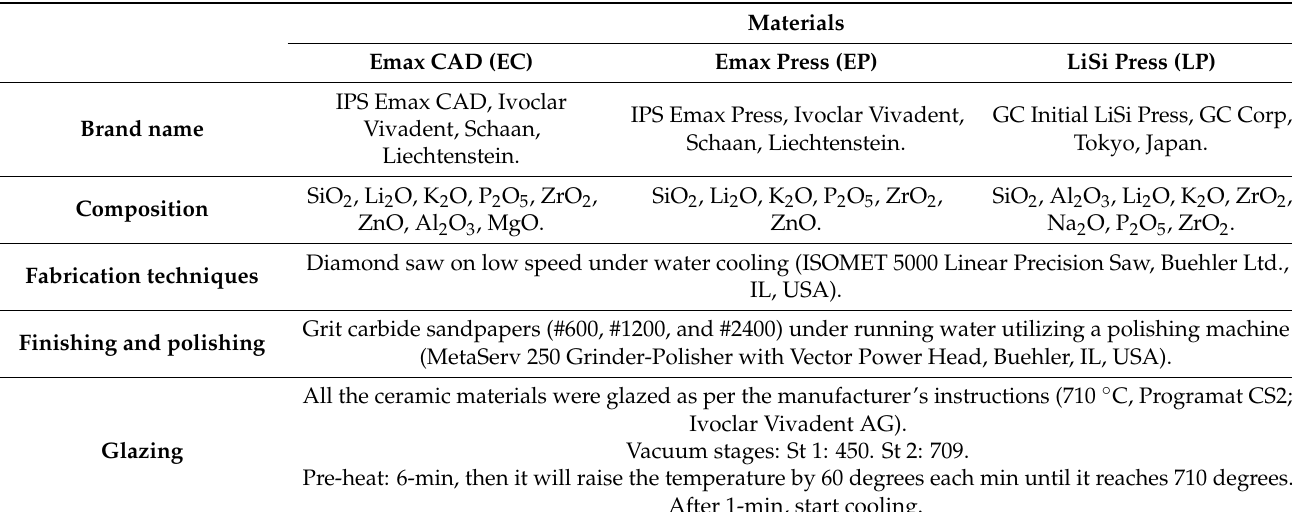
Table 1. Materials used in the present study (specification and manufacturing